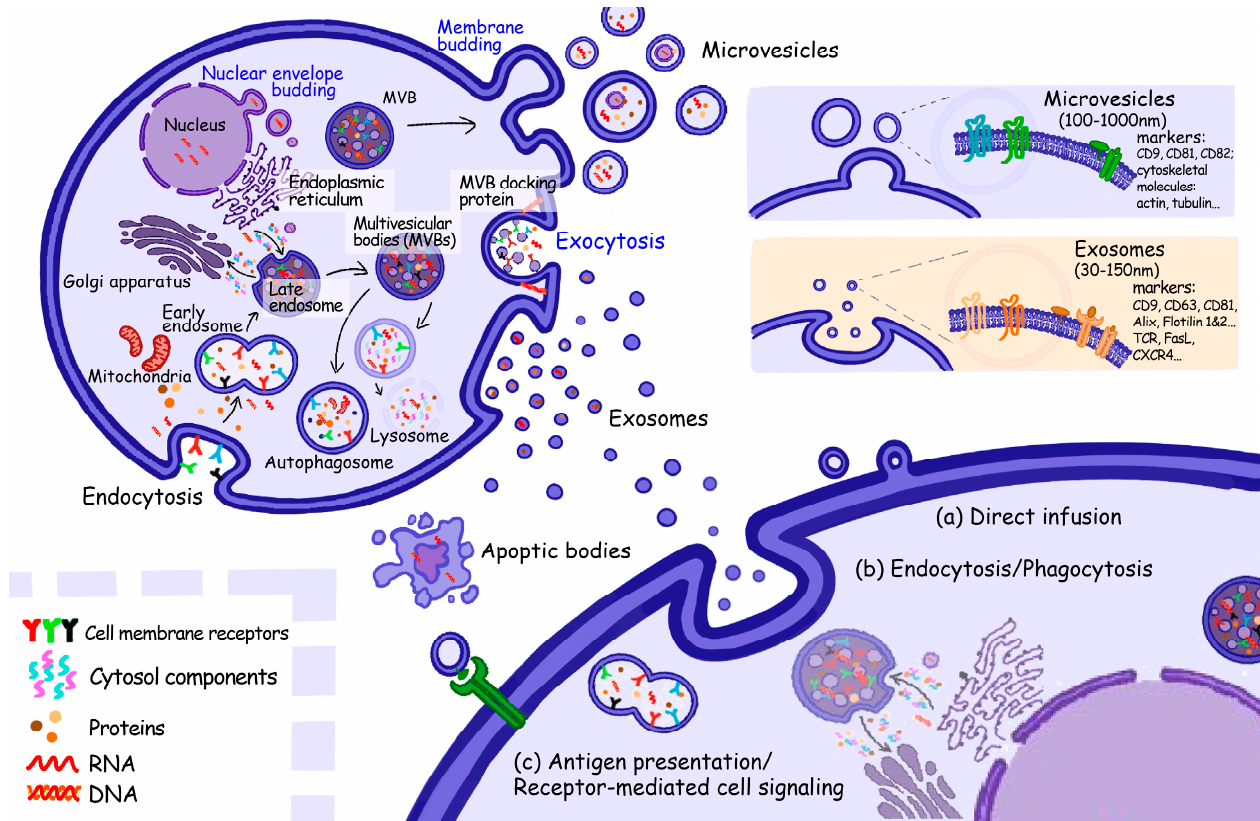
Figure 1. Biogenesis of EV subtypes and their transporting mode. Early endosomes sprout inwards from the cell membrane to form intraluminal vesicles, engulf intracellular components (such as RNAs, proteins, and other metabolites), transform into multivesicular bodies and then release exosomes into extracellular space. As for microvesicles, they bud from plasma membrane, and accepted by recipient cells via ( a ) direct fusion, ( b ) phagocytosis, ( c ) receptor-mediated or not endocytosis. EVs could be identified and extracted by liquid biopsy as cell-free DNA and circulating tumor